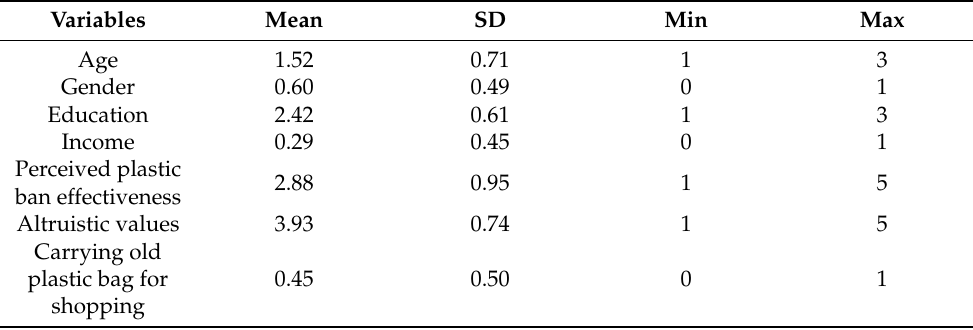
Table 2. Descriptive statistics for the variables in the study.